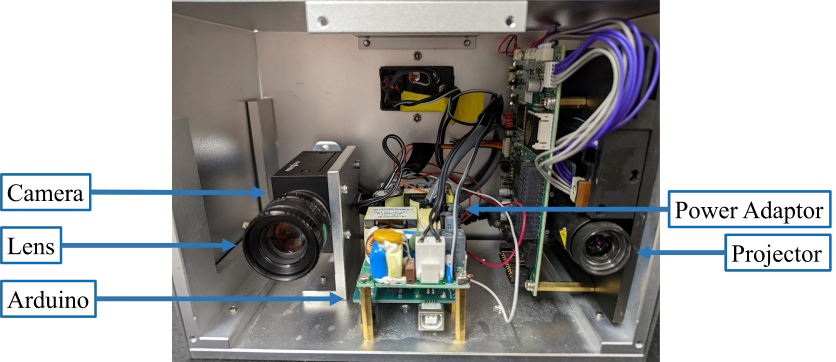
Figure 5. Photograph of our prototype